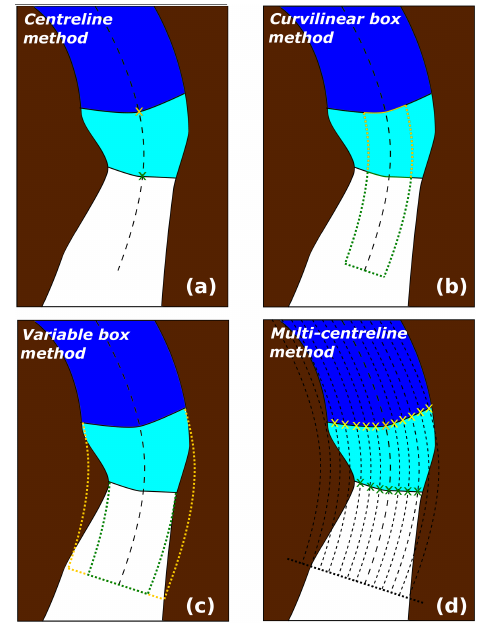
Figure 1. Methods of margin change quantification that can be ap- plied in MaQiT. Example shows the retreat of a tidewater glacier with ice (white), the former glacier extent (light blue) and open wa- ter (dark blue). (a) The centreline method takes the linear distance from the start of the centreline to the first point of intersection be- tween the centreline and the margin. (b) The curvilinear box method generates a box of a user-defined fixed width that is closed at its downstream edge by the digitised margin, with a one-dimensional measure of the distance from the start of the centreline obtained by dividing the box area by the box width (note that yellow box margin also extends to the start of the centreline). (c) The variable box method operates on the same principle as the curvilinear box method, though box width is automatically defined by MaQiT as the total distance from the end nodes to the centreline. (d) The multi- centreline method operates on the same principle as the centreline method, though multiple, regularly spaced lines are used to build a two-dimensional representation of margin change, with the output using a colour scale to visualise